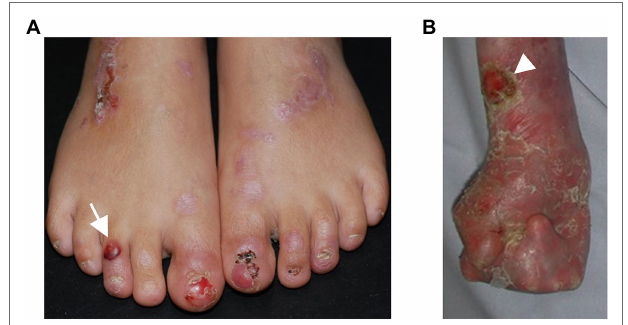
FIGURE 1 | Phenotypic variability in dystrophic epidermolysis bullosa. (A) A 6-year-old patient with recessive DEB and residual collagen VII expression has blisters (arrow) and erosions on the feet. The nails are dystrophic or absent, scars and erythematous maculae occur after healing of the lesions. (B) A 27-year-old patient with severe RDEB and complete lack of collagen VII expression suffers from severe skin fragility, chronic wounds (arrowhead), and pronounced, progressive fibrosis of the skin, resulting in mitten deformities. The skin appears inflamed with redness and crusts in areas of healed